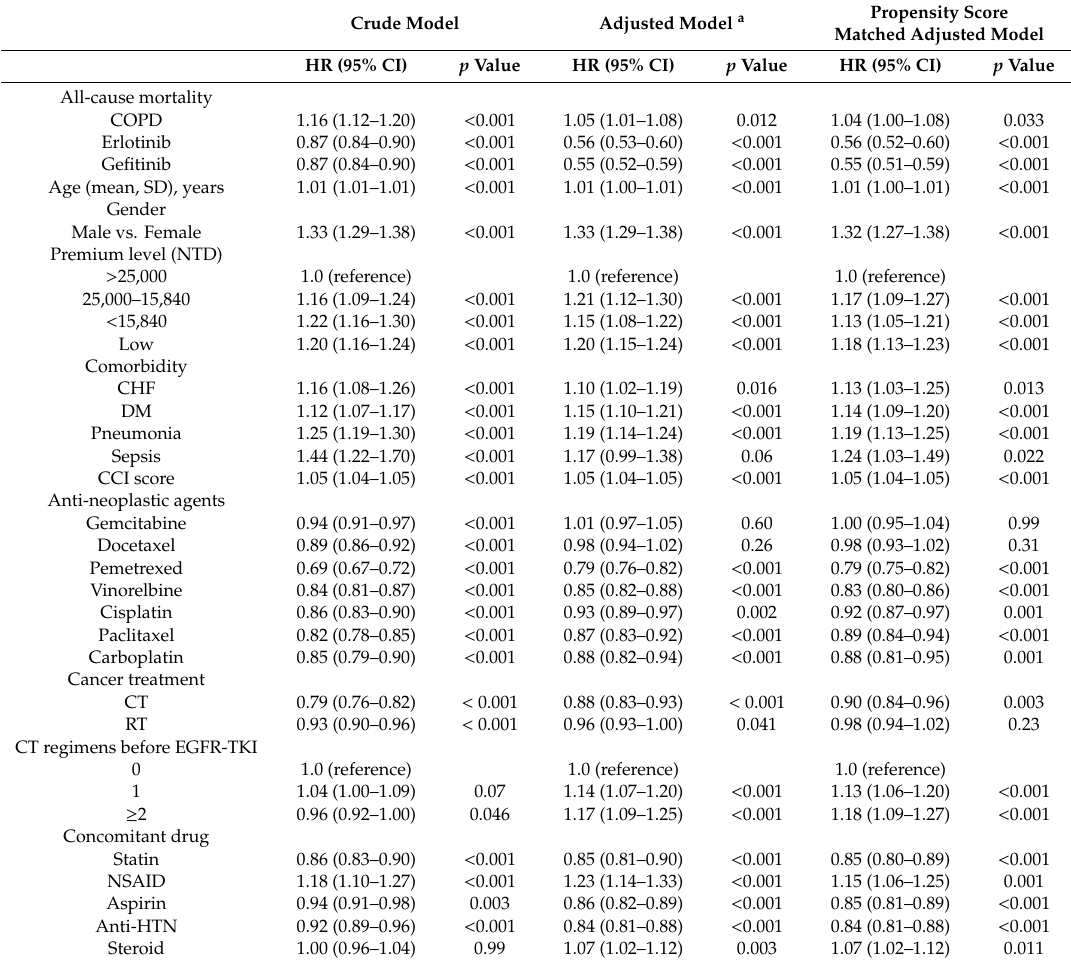
Table 2. Comparison of the hazard ratios (HRs) of death for all clinical